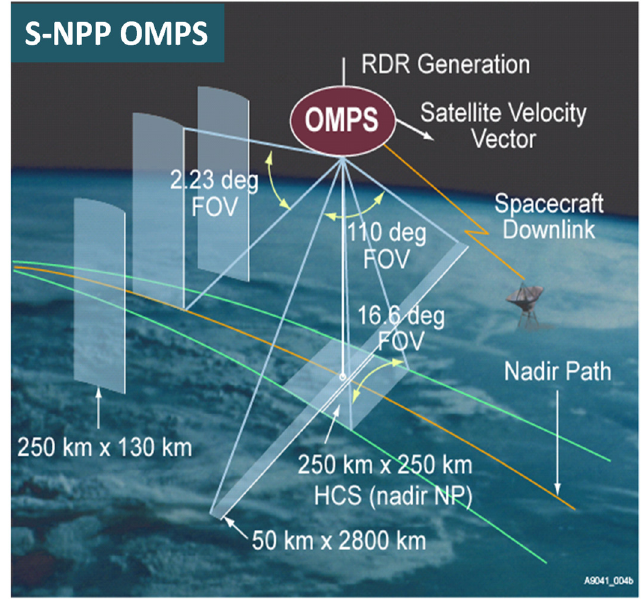
Figure 1. Geometry of SNPP OMPS NM and NP cross-track and along-track, and Limb Profiler (LP) cross-track, along-track, and vertical observations [32,41].